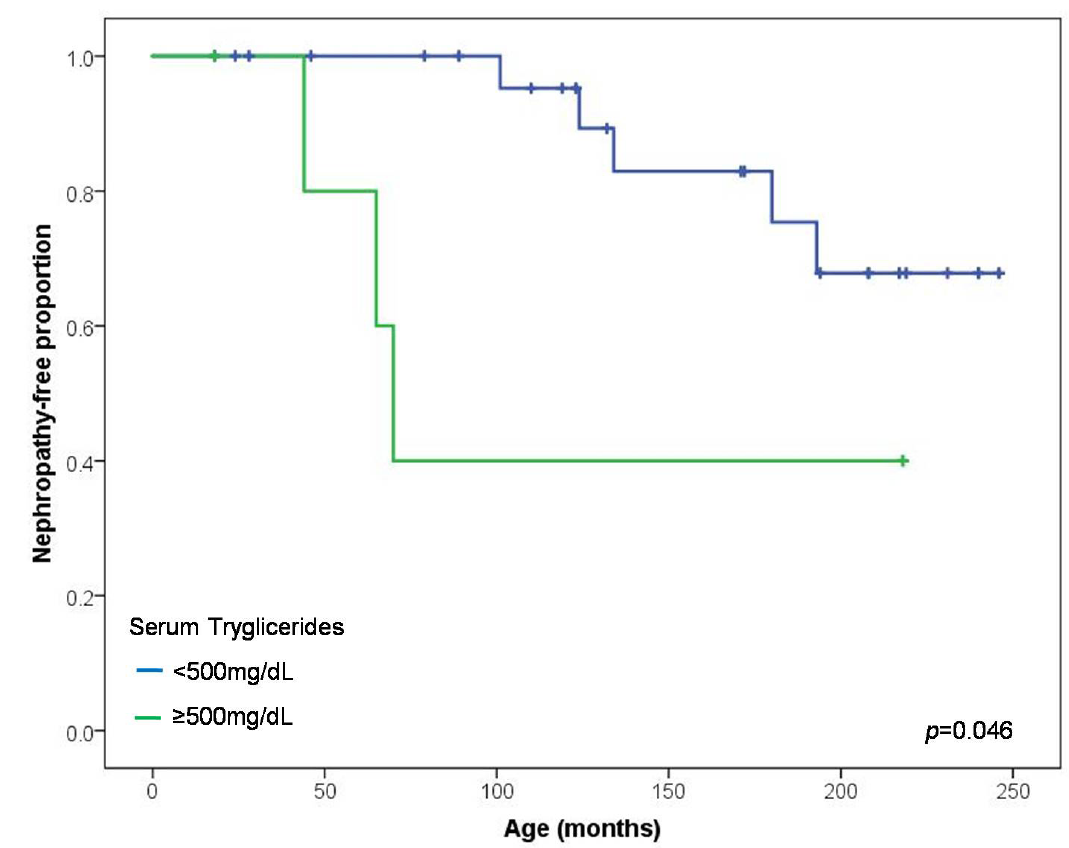
Figure 6. Kaplan-Meier survival curve of nephropathy-free progression in GSD I based on three-year mean triglyceride concentration. p value between both groups is